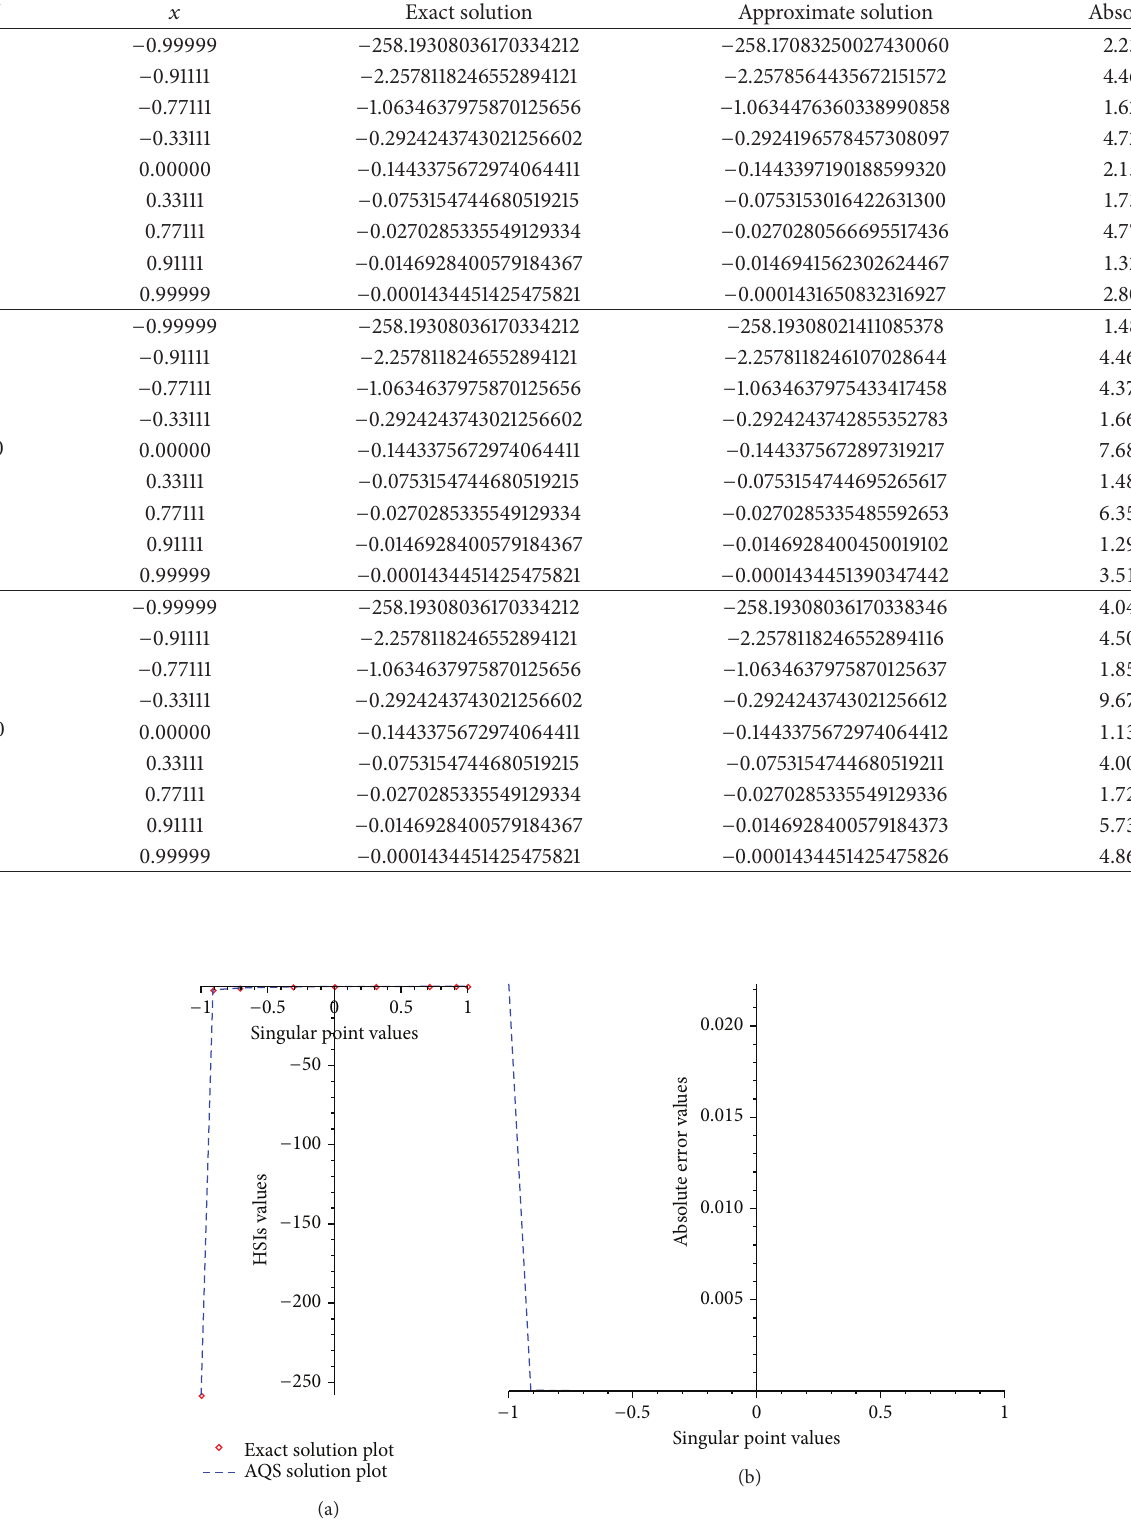
Figure 3: (a) Exact and AQS solutions when 𝑁 = 10 and ℎ(𝑡) = 1/(2 + 𝑡) and (b) absolute error between exact and AQS solution when 𝑁 = 10 and ℎ(𝑡) = 1/(2 + 𝑡)